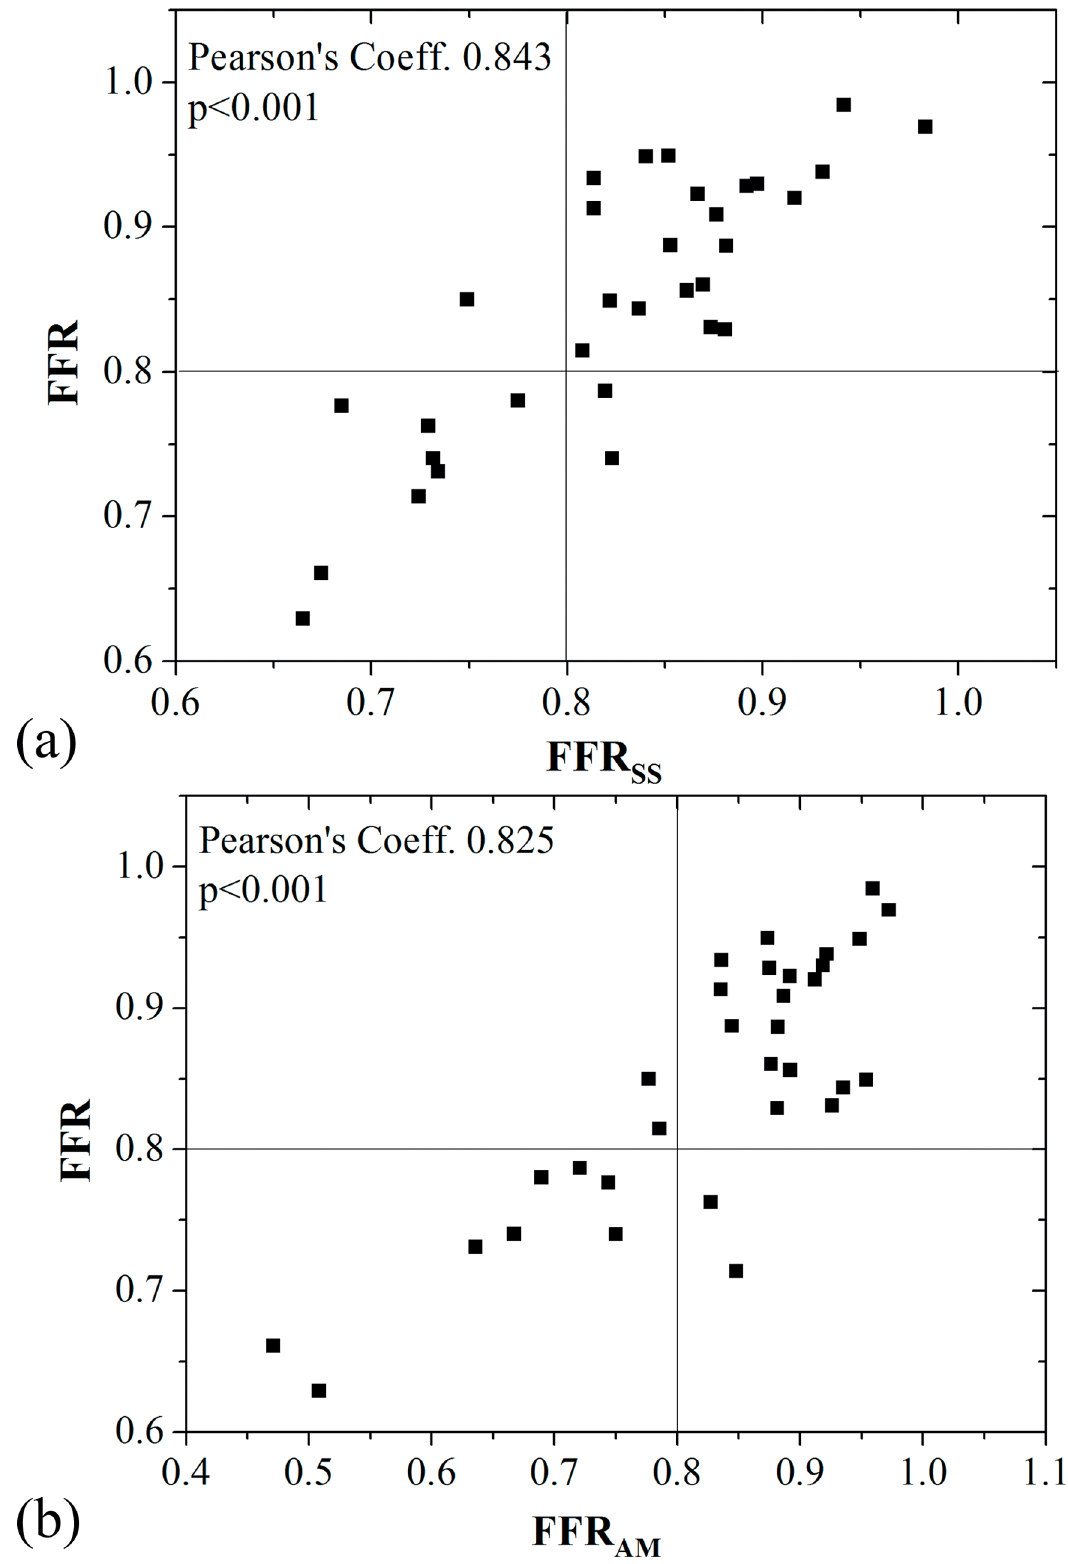
Fig 4. Correlation between FFR with (a) FFR SS and (b) FFR AM for a total of 32